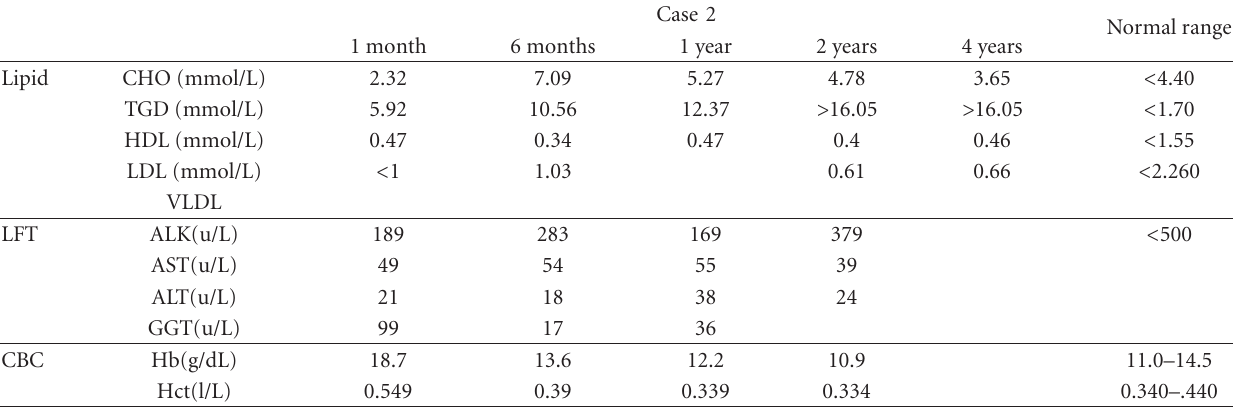
Table 2: Results of the Lipid profile, liver function, and complete blood count for SA at 1 month, 6 months, 1 year, 2 years, and 4